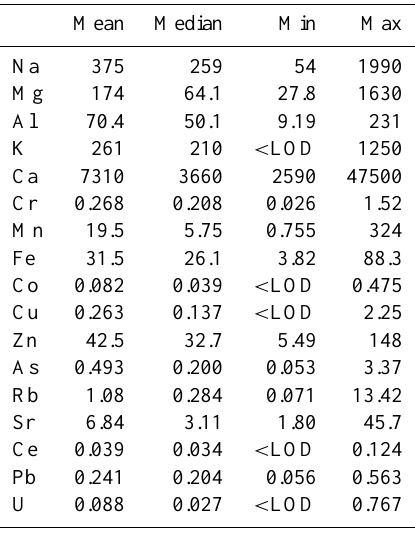
Table 1. Basic statistics of elemental concentrations measured in the samples of Vukuši´c ice core. If the concentration of a particular element is below the Limit of Detection (LOD) then LOD/2 was used in calculating the mean concentration. To avoid a bias due to this artificial substitution only those elements are reported for which less than four samples were below LOD. Value given in ngg − 1